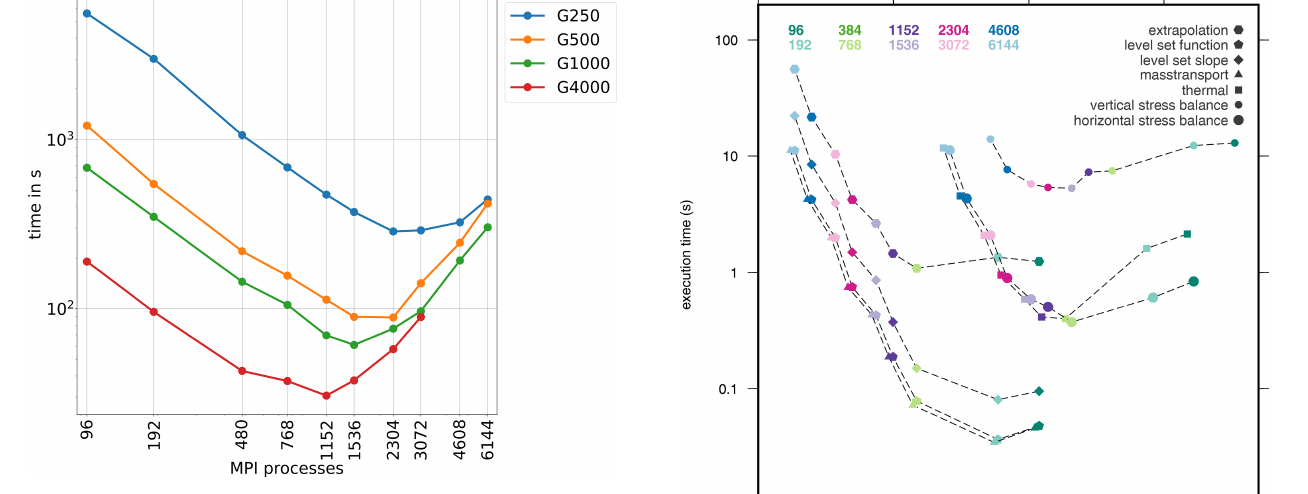
Figure 9. Runtime for various grid resolutions.